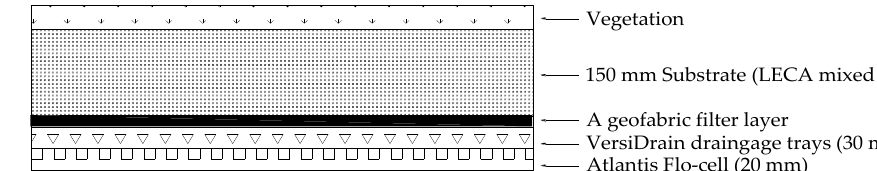
Figure 4. A cross-section of VU’s green roof selected for modeling in this study.